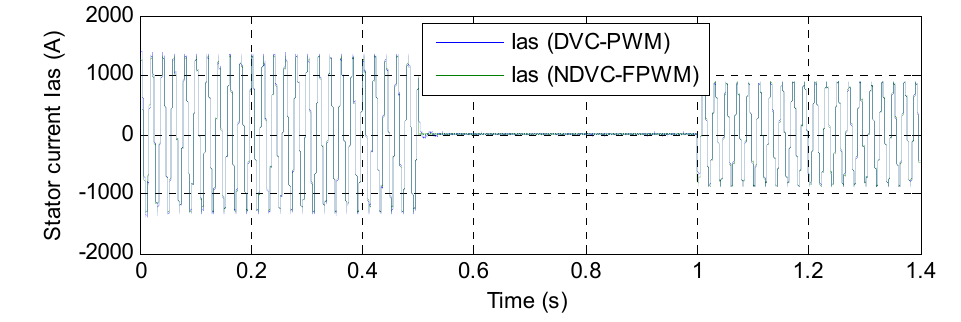
Figure 18. Torque.